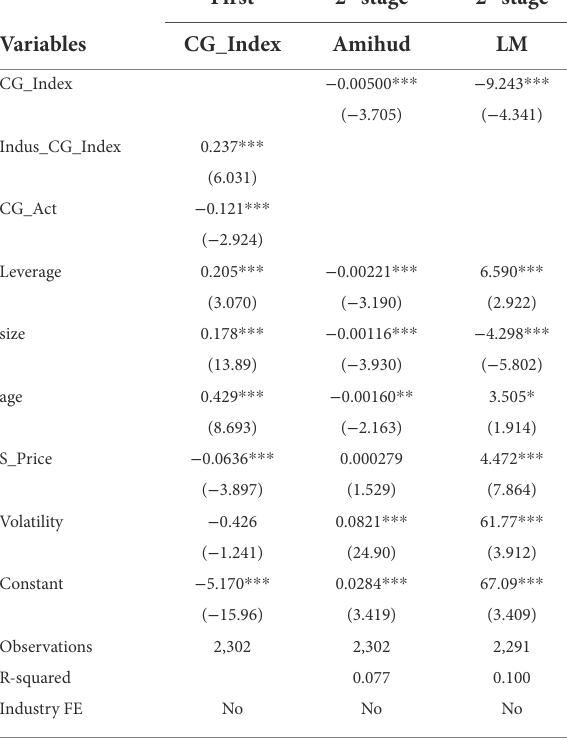
TABLE 10 Institutional ownership and stock liquidity (OLS Regression).